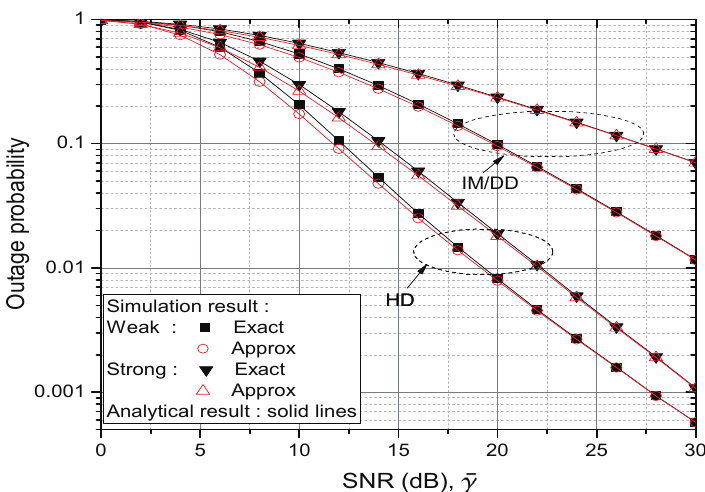
Figure 3. Comparison of CDFs (equivalently, OP) from γ e and γ a ; δ = 6.7 under weak or strong turbulence, respectively.